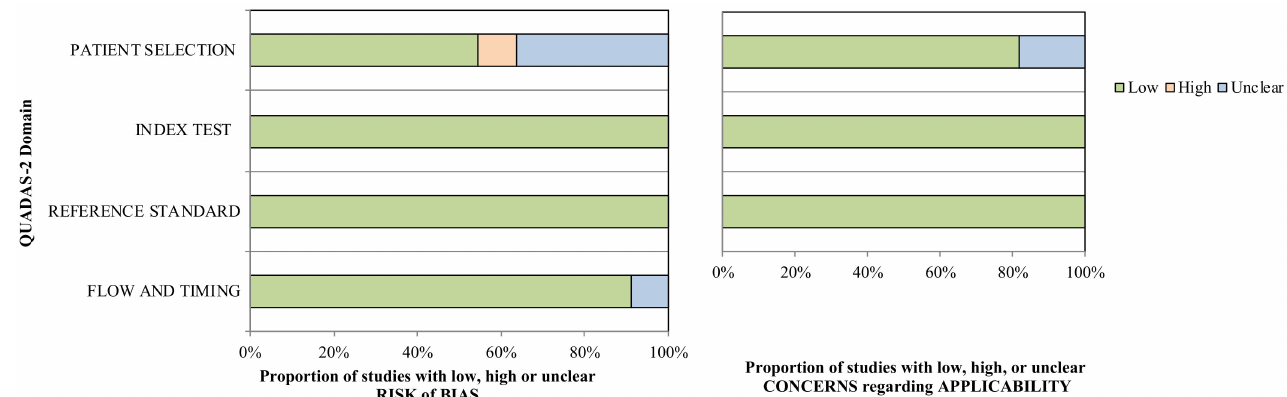
Figure 2. QUADAS-2 risk of bias and concerns of applicability chart; QUADAS-2: Quality Assessment of Diagnostic Accuracy Studies version 2.